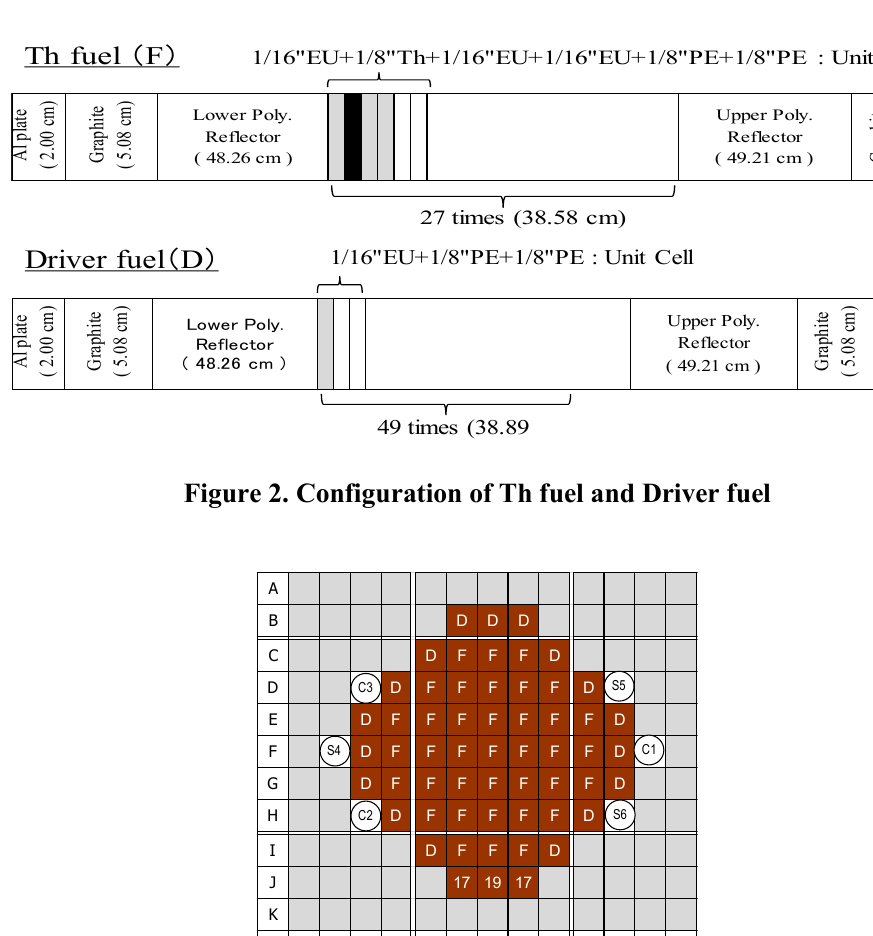
Figure 1. Schematic view of KUCA solid moderator core.